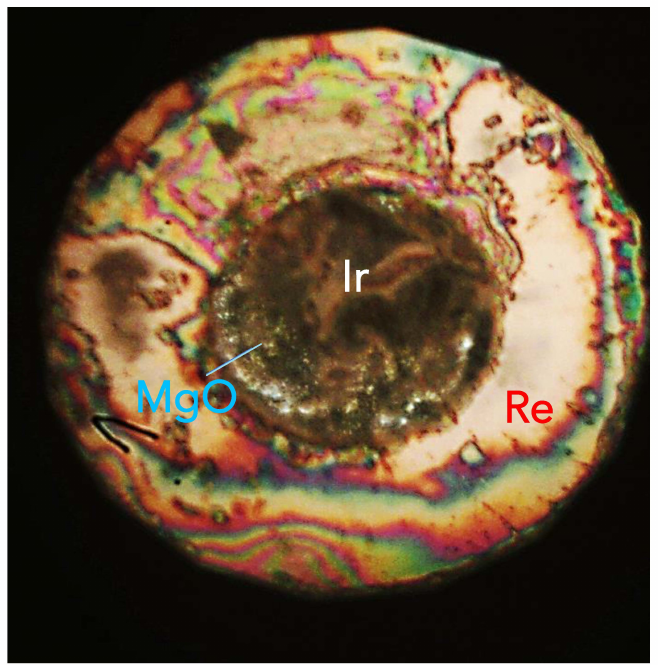
Figure 1. Photograph of the DAC high-pressure chamber after sample loading at ambient conditions. Despite the opacity of MgO, it is possible to observe the Ir embedded on it. The external ring is the Re